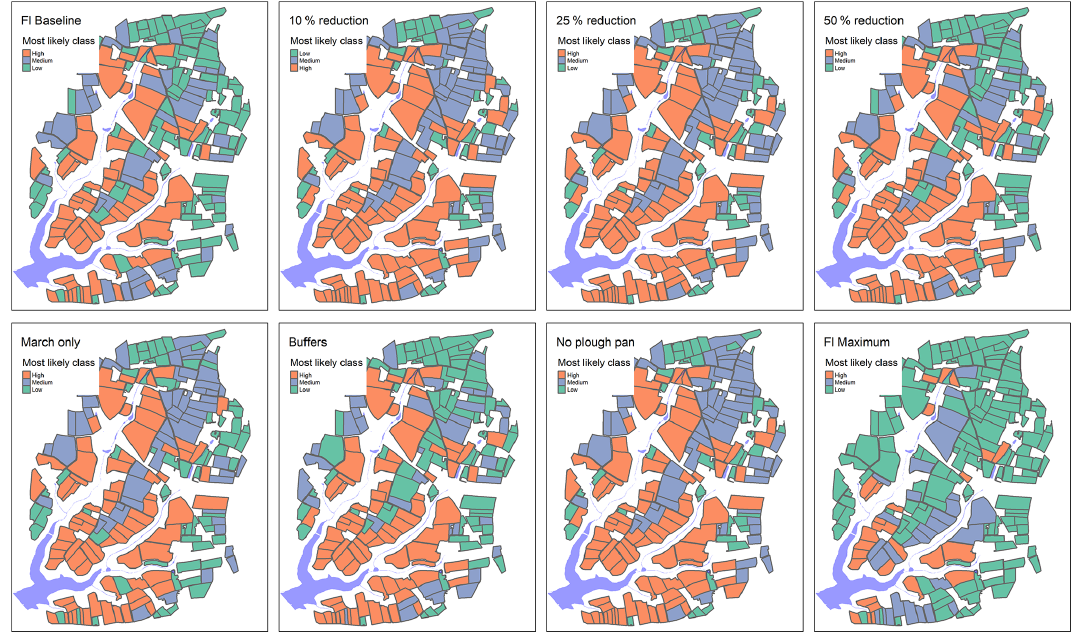
Figure B4. Most likely overland flow risk class for fluopyram under current application practices; with a 10%, 25%, or 50% reduction in the application rate; with a time shift of application to March; with additional field buffers; with no plough pan; and with all mitigation measures